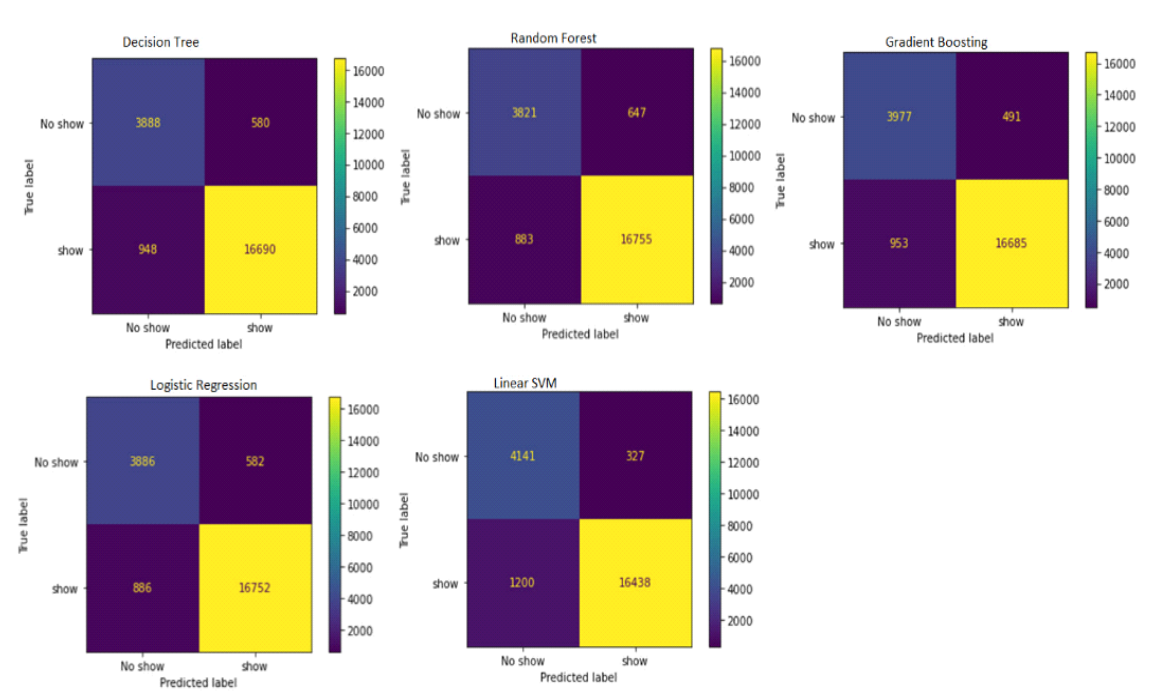
Figure 5. Confusion matrix for different machine learning